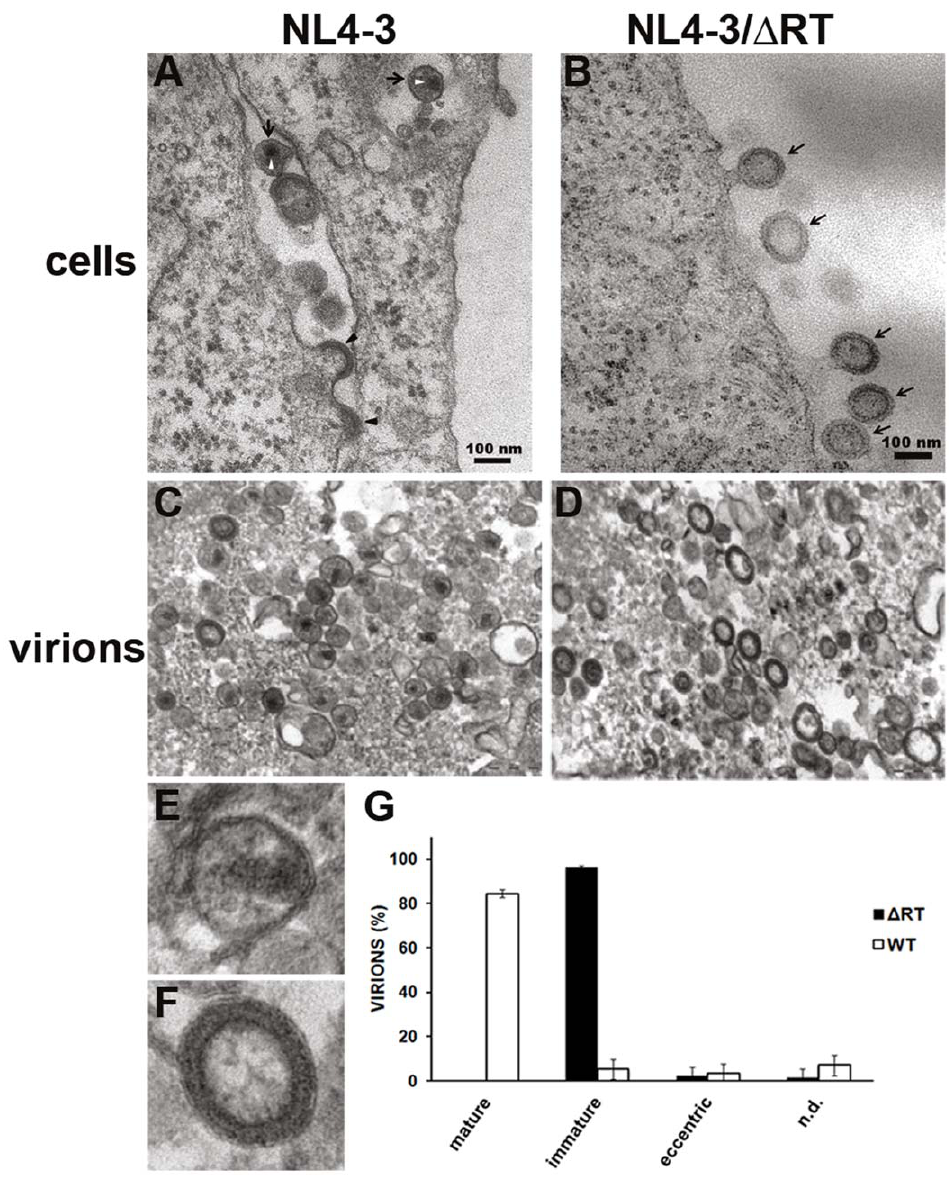
Figure 3. Analysis of virion morphologies by electron microscopy. (A) Electron micrographic analysis of 293-T cells transfected with pNL4-3. Mature virions (black arrows) show their characteristic core (white arrow heads). Budding particles (black arrow heads) are also present. (B) Electron micrograph showing immature viral particles budding from 293-T cells transfected with pNL4-3/ D RT (black arrows). (C) Electron micrographic analysis of pNL4-3 purified viruses showing mature, immature and eccentric virion forms. (D) Electron micrograph of pNL4-3/ D RT purified virions in which only immature virion forms can be observed. (E and F) NL4-3 and NL4-3/ D RT virion magnifications respectively are shown. (G) Virion form measurements of NL4-3 versus NL4-3/ D RT. NL4-3/ D RT virion conformation was mostly immature and no mature virions were observed. On the other hand, NL4-3 virions were mainly mature. Error bars represent standard deviations. Samples were imaged using a Tecnai Spirit Twin electron-